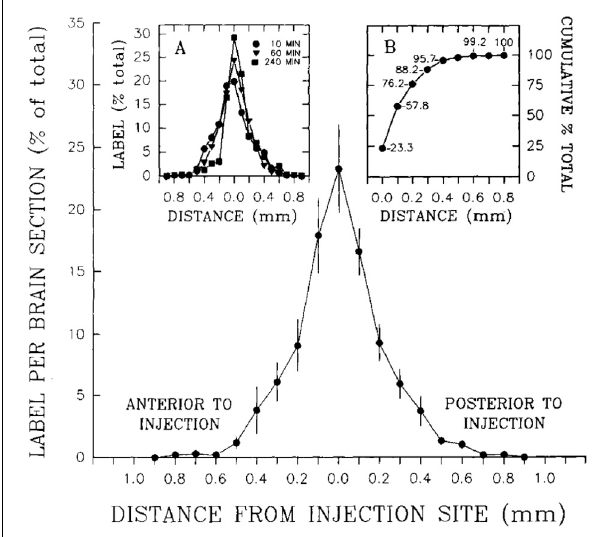
FIGURE 3 | A reproduction of Figure 2 of Stanley et al. (1993a,b,c), which describes the relationship between the percent recovery of radiolabeled neuropeptide Y (10nl) within brain tissue 10min following its injection into the brains of rats. The percent recovery values are plotted against distance from the injection site in millimeters. Brain tissue sections were taken at 0.1mm intervals from each injection site and the amount of radioactive NPY analyzed. The left inset in this figure ( labeled A ) shows the same relationship, but with 10, 60, and 240min recovery times compared. The right inset ( labeled B ) shows the cumulative recovery of the radioactive peptide in relation to the distance at which the recovery was achieved; the numbers indicate cumulative percent recovery values. Note that the distance scale marks only the spread of the solution along the anterior-posterior axis, and does not speak necessarily to movement of the injected solution along any other dimensions. Reproduced with permission from